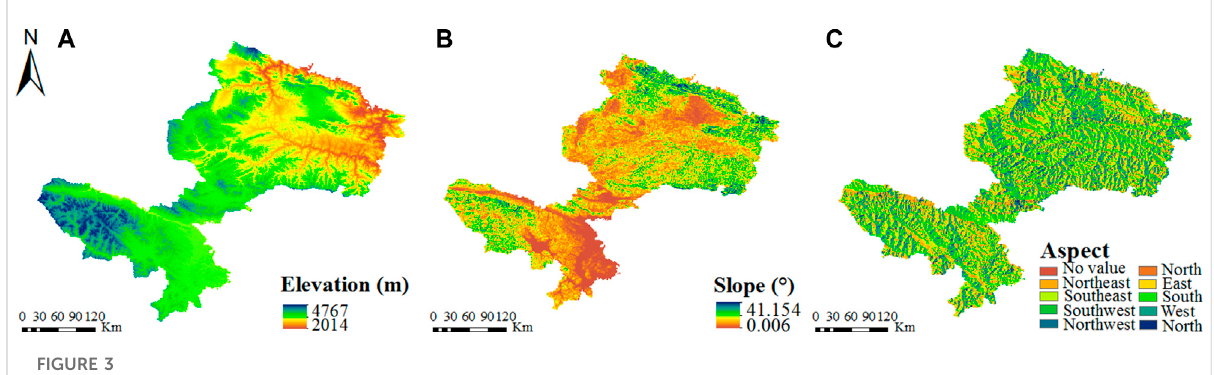
FIGURE 3 Various topographical factors: (A) elevation, (B) slope, and (C) aspect.